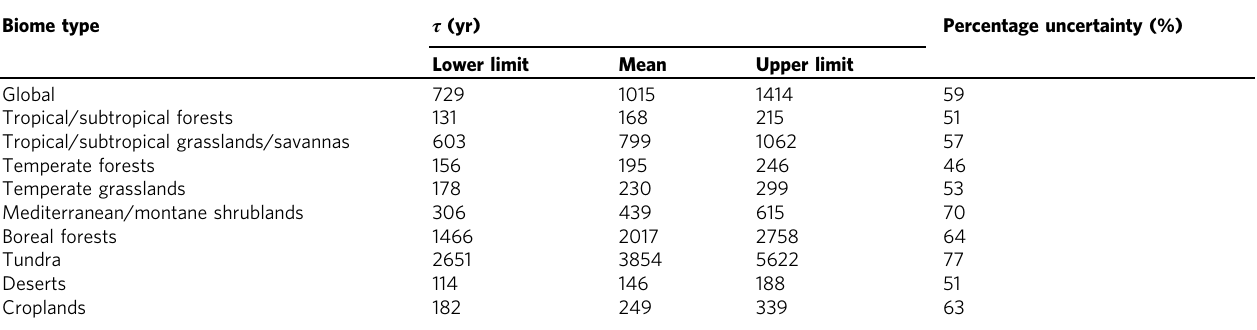
Table 1 Mean turnover times ( τ ) of soil organic carbon in the subsoil (0.3 – 1 m soil layer) and its uncertainty in global biomes